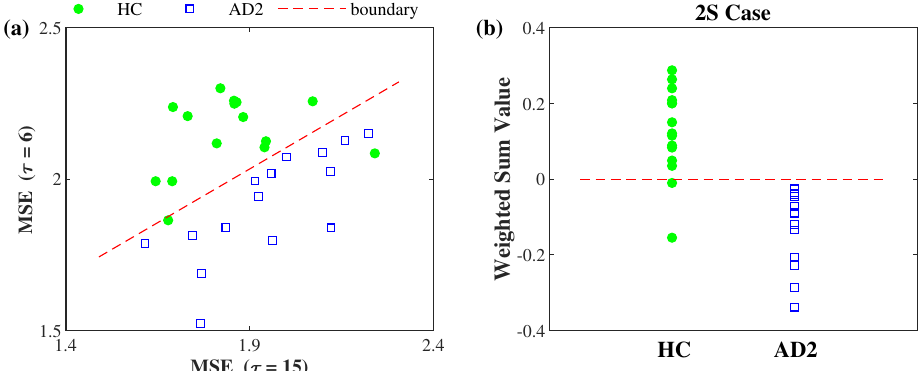
Figure 1. ( a ) The MSE ( τ = 6) vs. the MSE ( τ = 15) of the 30 EEG signals recorded from the T4 electrode. The 15 circle and 15 square symbols are from 15 healthy subjects and 15 patients with moderate to severe AD, respectively. The red dashed line is the differentiating boundary. ( b ) The weighted sum values of the 30 signals. The red dashed line is the differentiating boundary with threshold value 0.